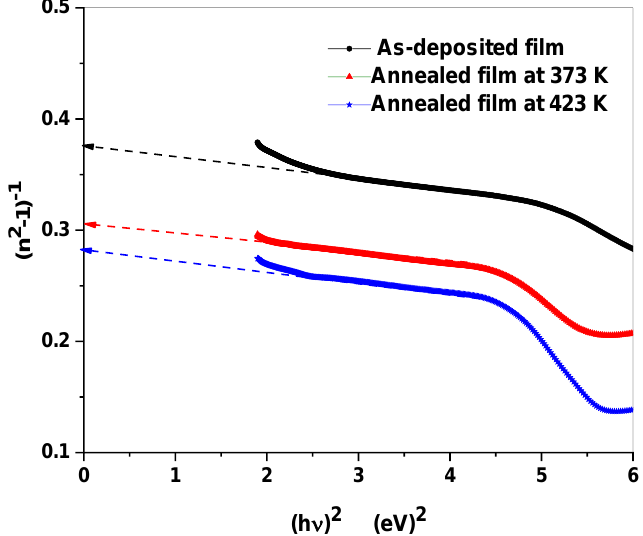
Figure 17. Plot of (n 2 − 1) − 1 fi lms versus (ℎ𝜈) 2 for compound 4 thin films.